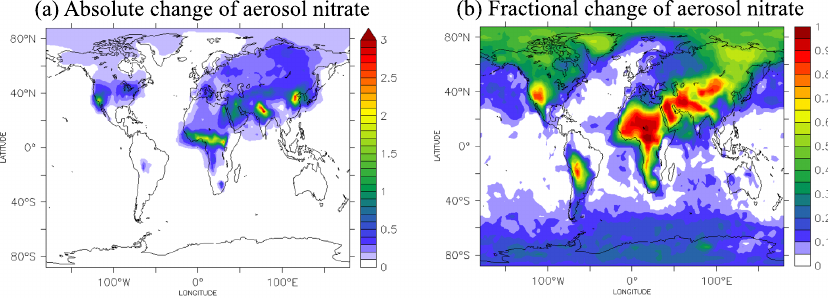
Figure 5. (a) Absolute (in µgm − 3 ) and (b) fractional change of the predicted average near-surface aerosol nitrate by ignoring the effect of the reactive dust components on its formation, during the years 2005–2008. A positive change corresponds to a decrease after assuming chemically inert